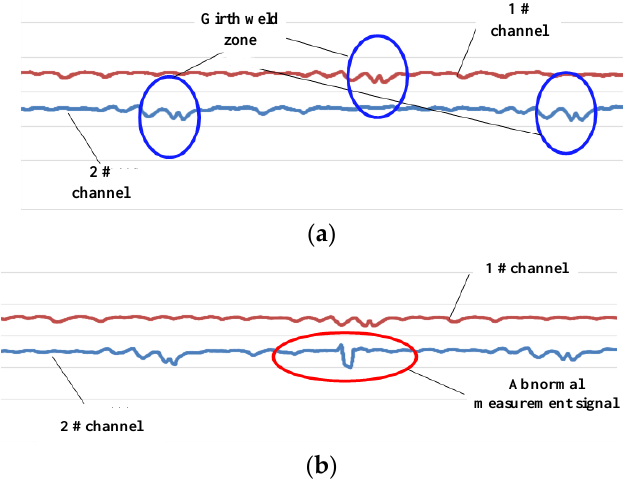
Figure 26. Tension test stress measurement results. ( a ) Stress measurement results of locating the section of the inner wall without manual intervention. ( b ) Stress measurement results from locating the section of the inner wall during manual intervention.